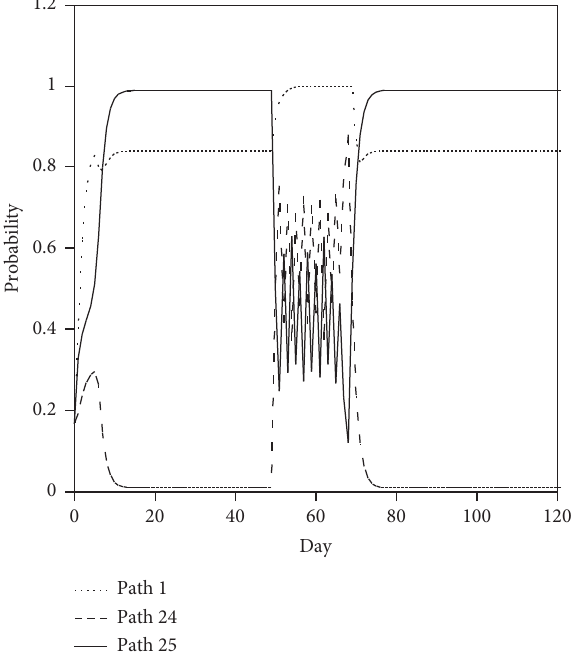
Figure 7: Day-to-day dynamics with drop in road